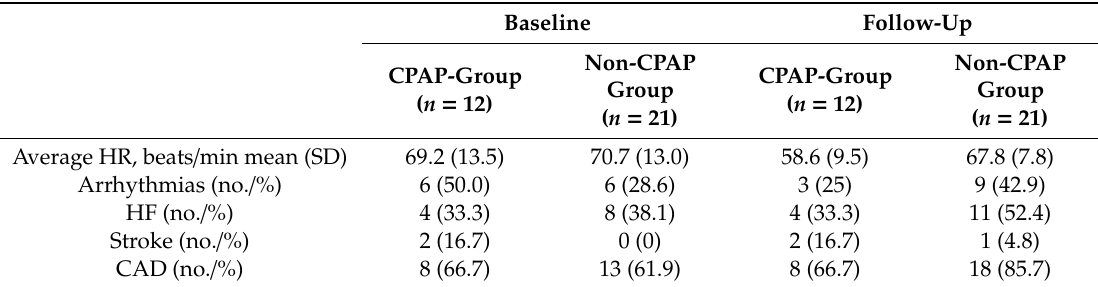
Table 7. Baseline and follow-up heart rate and cardiovascular